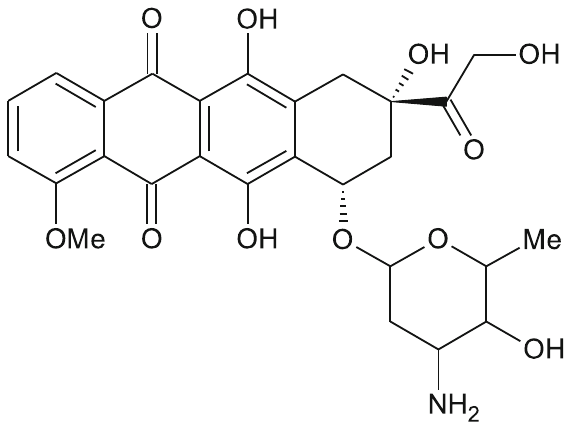
Figure 2. Chemical structure of DOX. Sourced with permission from Ref. [42].